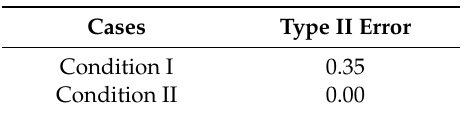
Table 2. Calculated type II